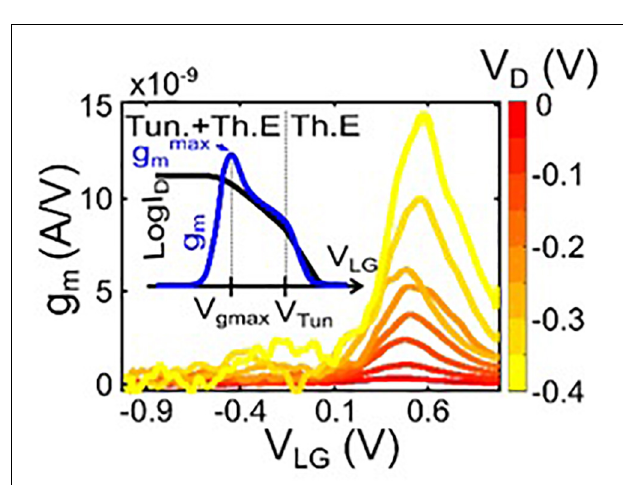
FIGURE 3 | Transconductance g m versus drain voltage (V D ) and liquid-gate voltage (V LG ) for one selected